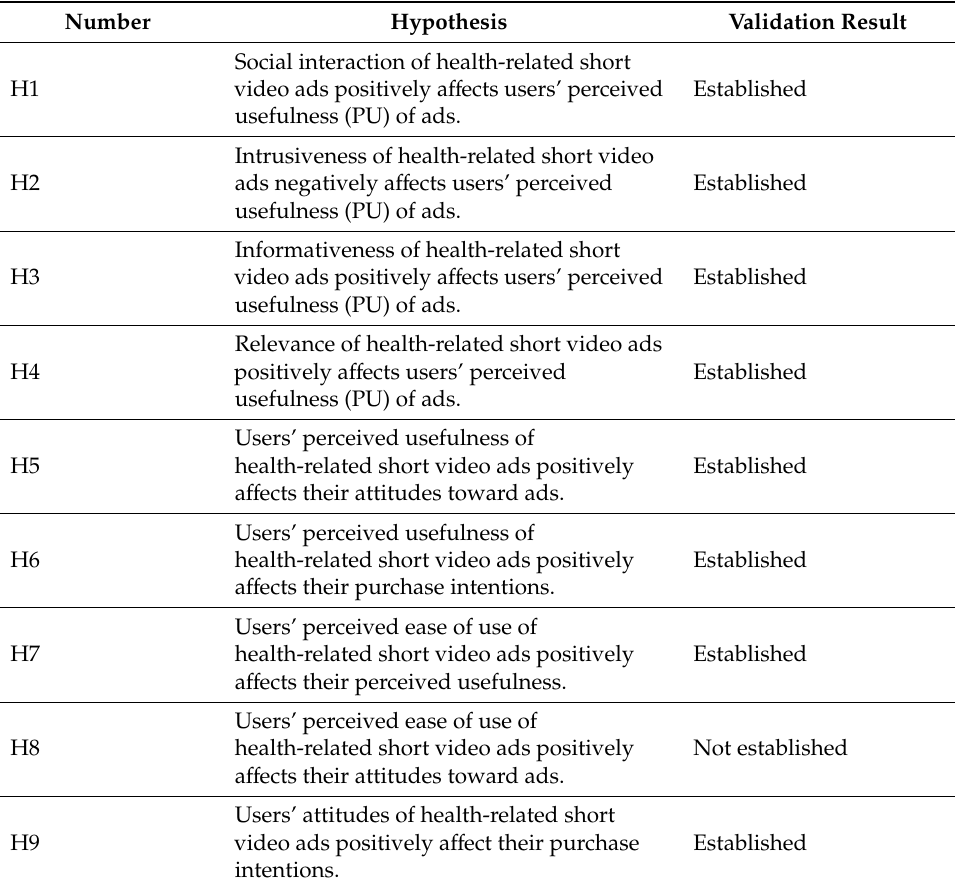
Table 7. Summary of hypotheses